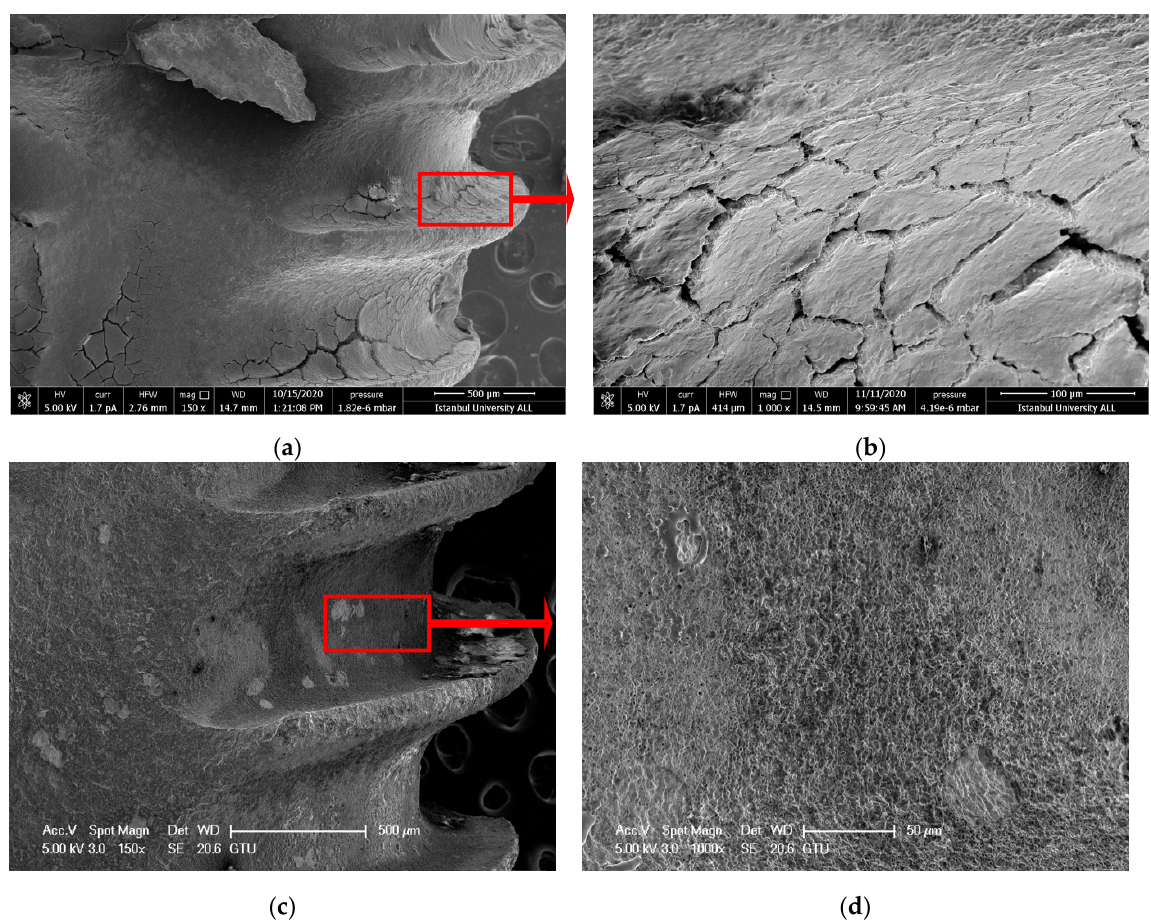
Figure 5. ( a , b ) SEM images showing the topography of untreated failed implant surfaces in ErL-LP group (150× and 1000×) ( c , d ) after intervention (150× and 1000×). Red arrows show the further magnification